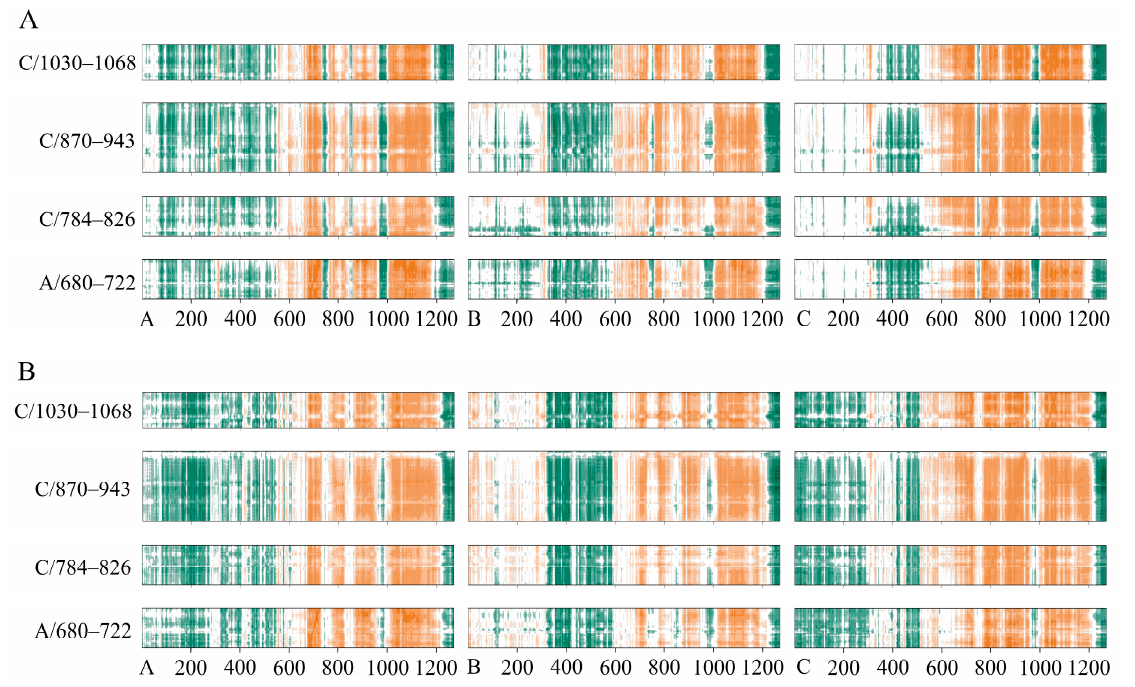
Figure 6. Dynamic cross-correlation maps for S in the ( A ) S closed simulation and ( B ) SFN-S closed simulation. Correlation values range from − 1 to +1; the positive values (sea green) indicate that 2 residues are correlated and negative values (orange) indicate that they are anti-correlated.